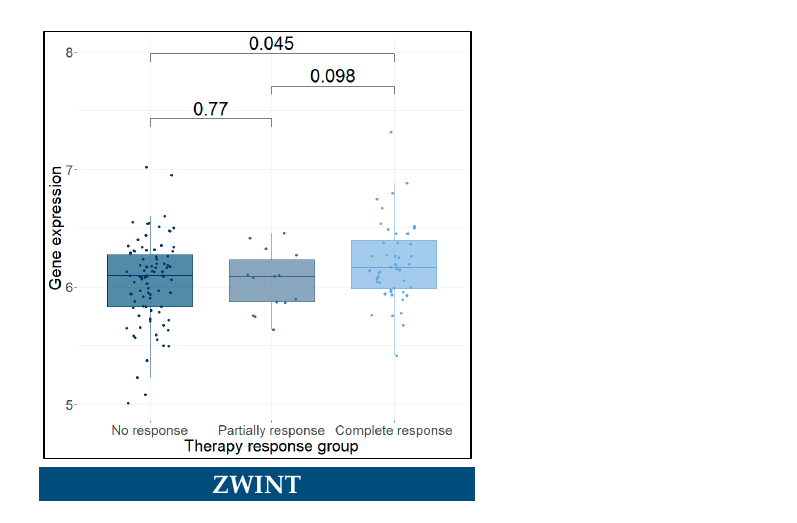
Figure 19. Significantly differentially expressed key hub genes between “No response”, “Partially response”, and “Complete response” to preoperative cisplatin-based chemotherapy groups of MIBC patients.